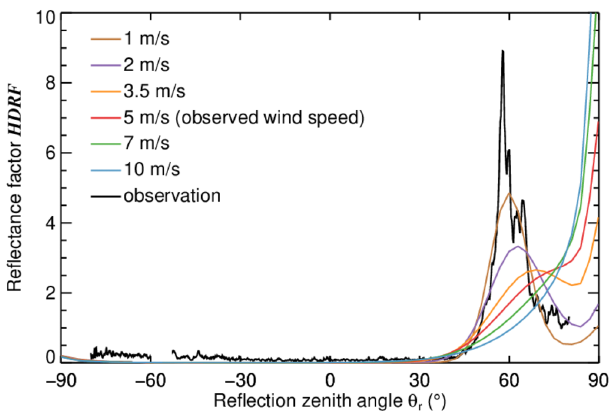
Figure 7. Cross-sections of the open-ocean HDRF along the so- lar principal plane simulated with different wind speeds (color- coded) between 1 and 10ms − 1 including the observed wind speed of 5ms − 1 . The black line corresponds to the separated open-ocean HDRF. The mean observed SZA also used for the simulation was 57.8 ◦